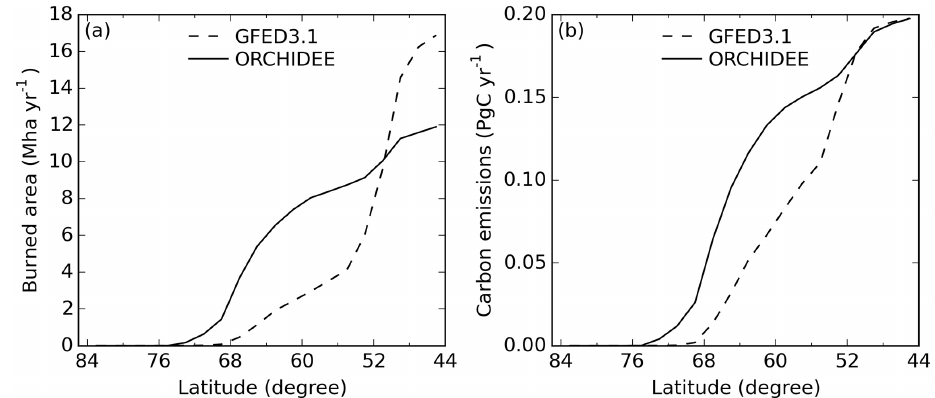
Figure 5. Cumulative latitudinal distribution of (a) burned area and (b) fire carbon emissions as given by the model simulation (solid line) and GFED3.1 data (dashed line). Emissions from agricultural fires are excluded from GFED3.1 data as they are not included in the model. Note that despite an underestimation in annual burned area, simulated fire carbon emissions are close to GFED3.1 data south of 52 ◦